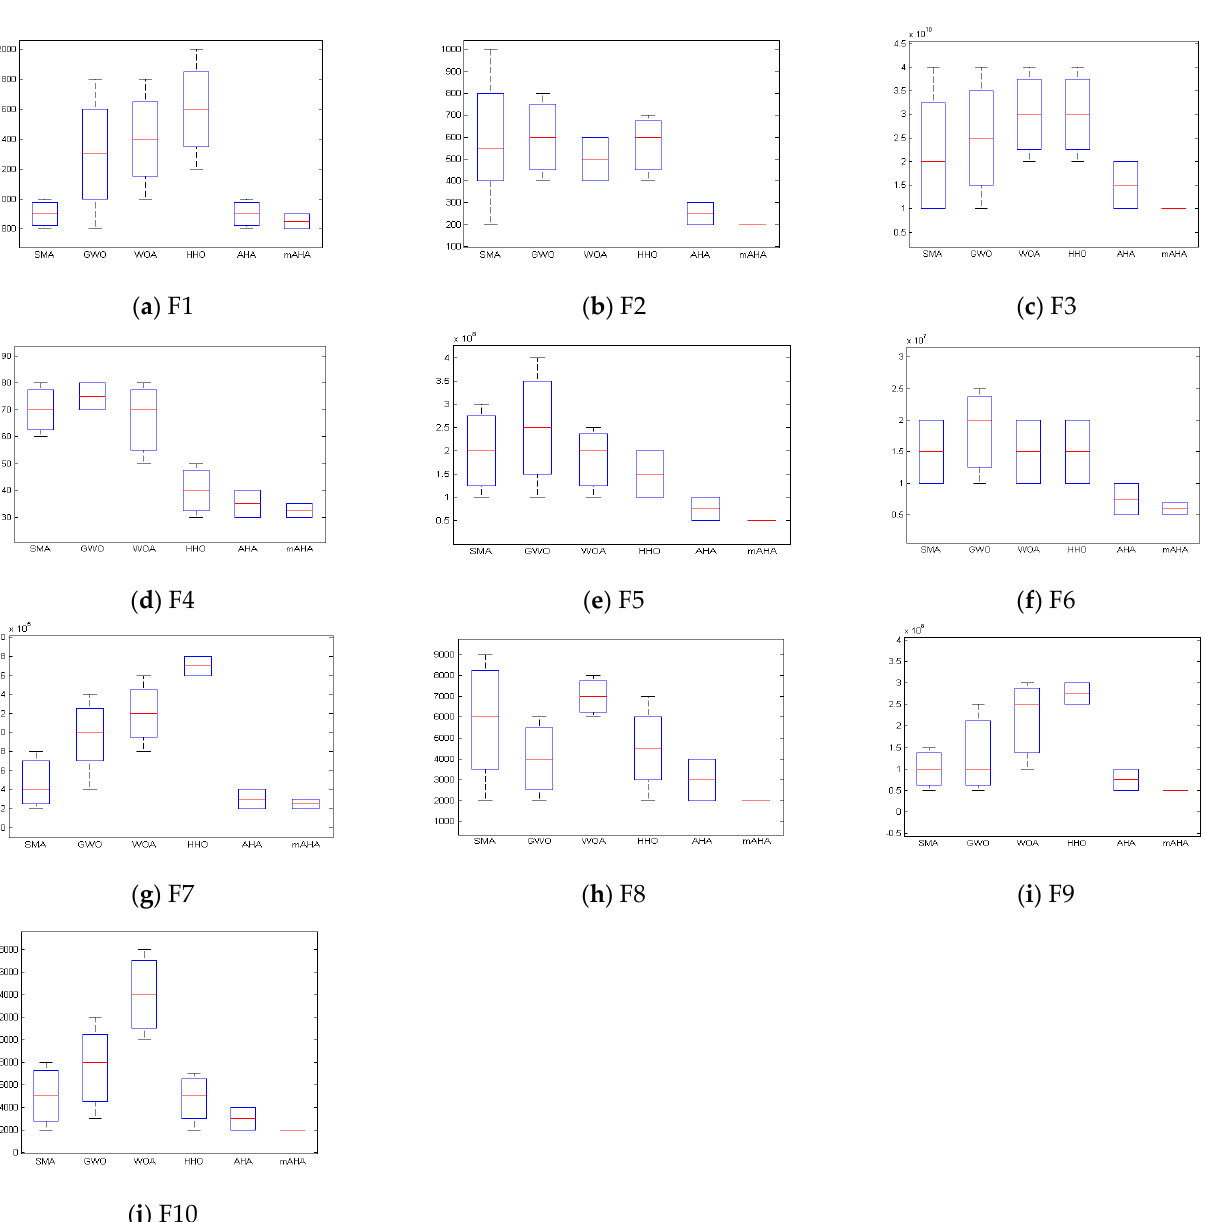
Figure 1. The convergence curves on the CEC’20 test suite have been obtained by the proposed mAHA and the competitor algorithms for 30 runs with Dim10.